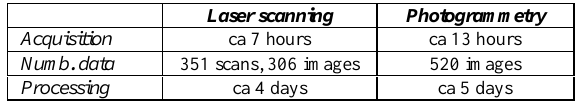
Table 1: A summary of the efforts for both